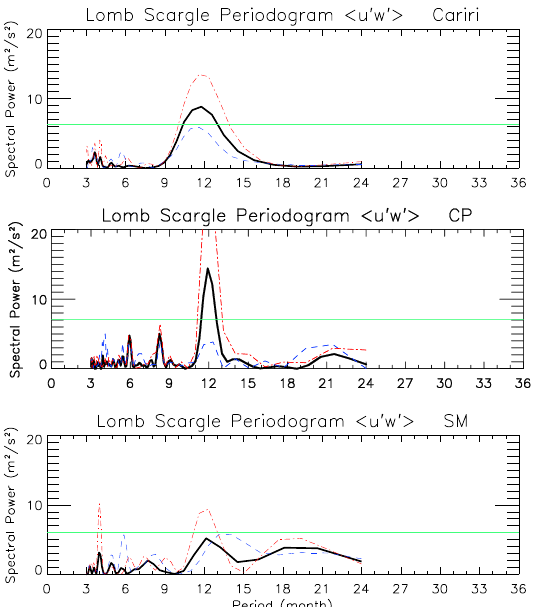
Figure 11. Lomb–Scargle spectral analysis of zonal component of GW momentum fluxes over São João do Cariri (top), Cachoeira Paulista (middle), and Santa Maria (bottom). The horizontal green straight lines show the 90% confidence levels. In all stations the solid black line represents the height-average profile, the blue dashed line corresponds to 89km altitude and the red dash-dot line corresponds to 92.5km